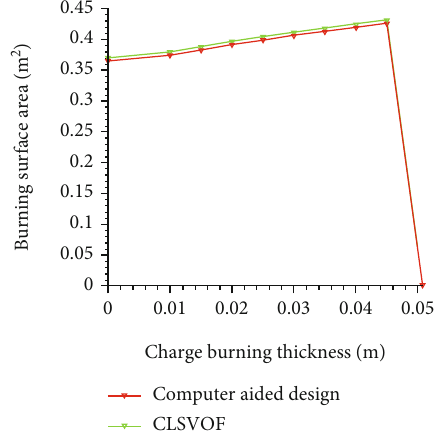
Figure 10: Comparison of burning surface area.